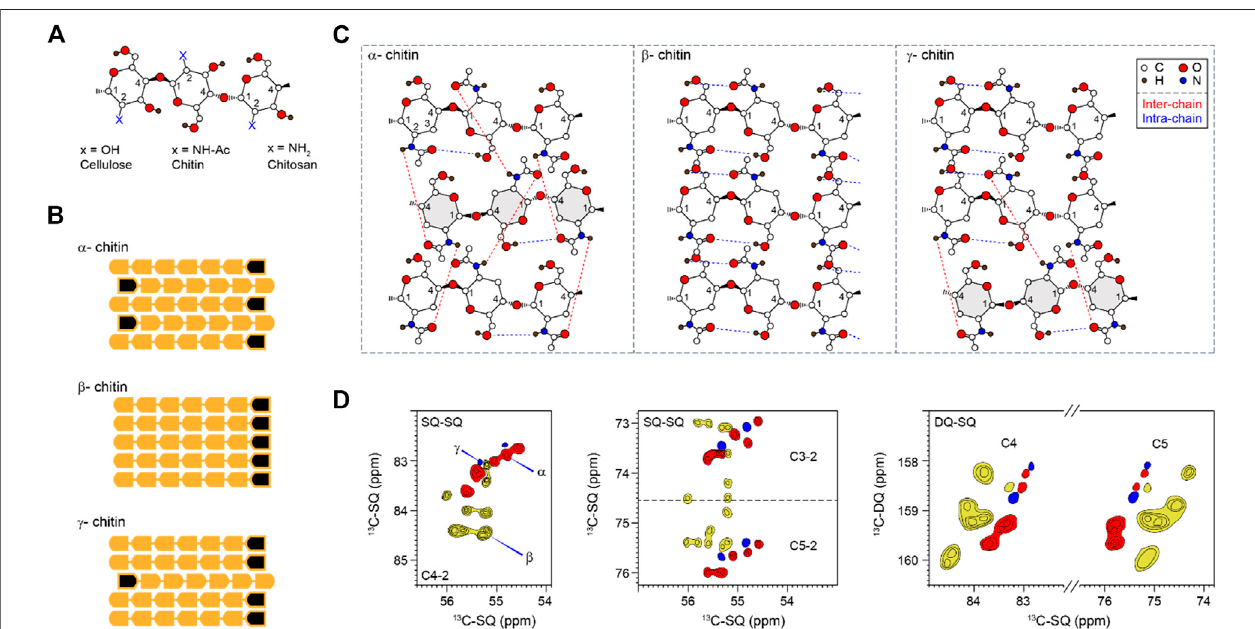
FIGURE 1 | Representative structures and NMR signals of chitin. (A) Substitutions at the C2 position for chitin and chitosan. (B) Polymorphic types ( α , β , and γ ) of chitinshowingdifferentchainorientations.Black marksdenotethe non-reducing ends ofchains. (C) Hydrogen-bonding patterns ofdifferentchitinallomorphs.Blueand red dash lines indicate intra-chain and inter-chain hydrogen bonds, respectively. The antiparallel chains in α and γ chitins are in grey. The hydroxyl at C3 is not shown to make the structure less complex. The structural schemes are adapted from (Rudall, 1963; Kameda et al., 2005; Sawada et al., 2012a). (D) 2D 13 C- 13 C correlation spectra simulated using literature-reported chemical shifts on model samples ( Supplementary Table S2 ). Representative C4-2 and C3/5-2 regions were shown for single-quantum (SQ)-SQ correlation spectra. The C4 and C5 region is also shown for a double-quantum (DQ)-SQ correlation spectrum. α , β , and γ are represented in red, yellow, and blue respectively. Contour lines represent the number of data sets used (and the number of overlapped